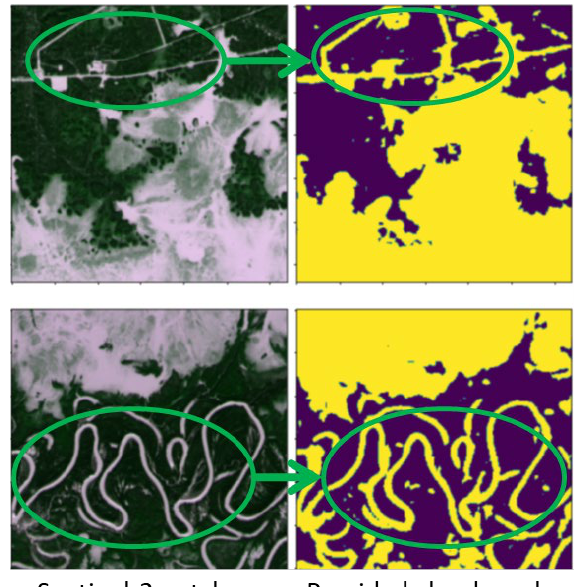
Figure 10. Probable issues with the original cloud